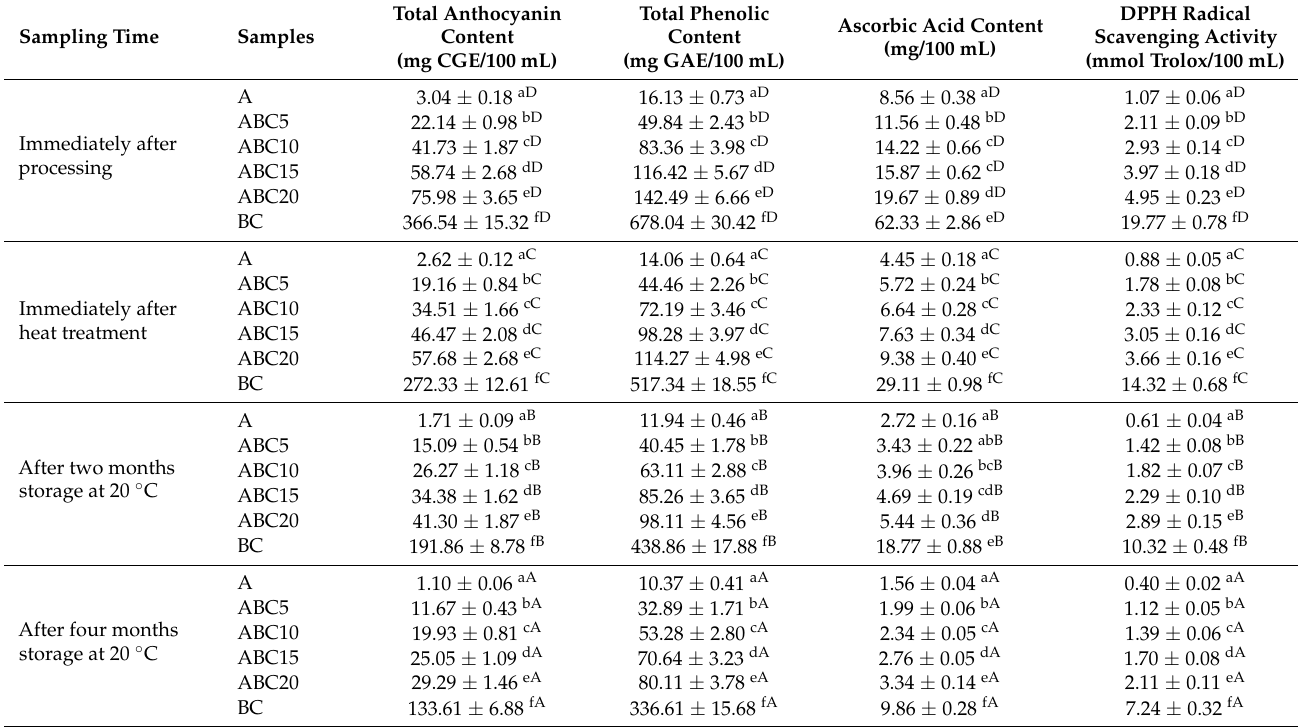
Table 2. Total anthocyanin, total phenolic, and ascorbic acid contents and the DPPH radical scaveng- ing activity of the tested juices immediately after processing, after the heat treatment, and after four months of storage